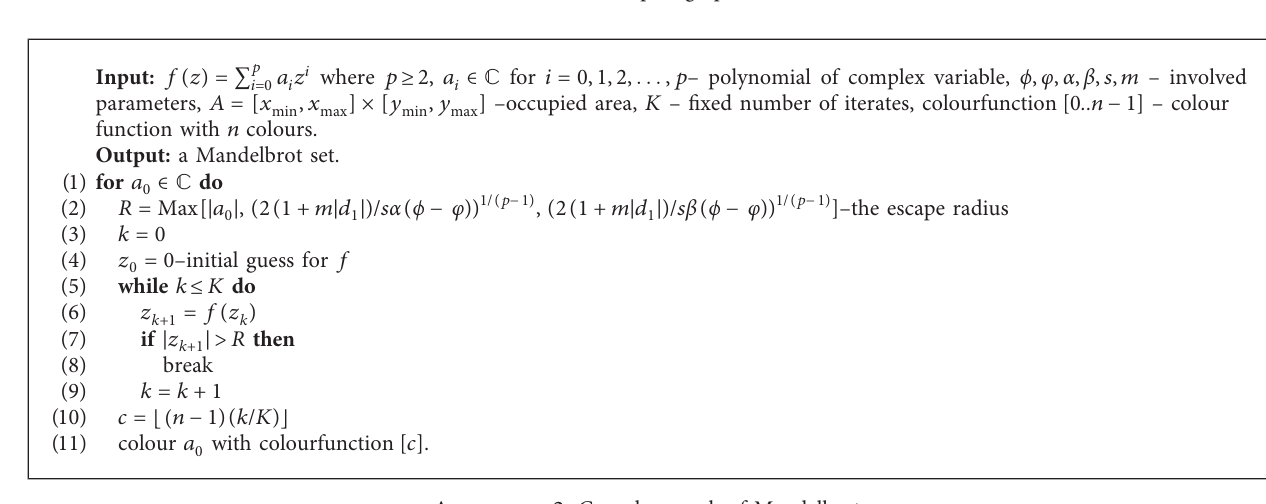
A LGORITHM 1: Complex graph of Julia set.